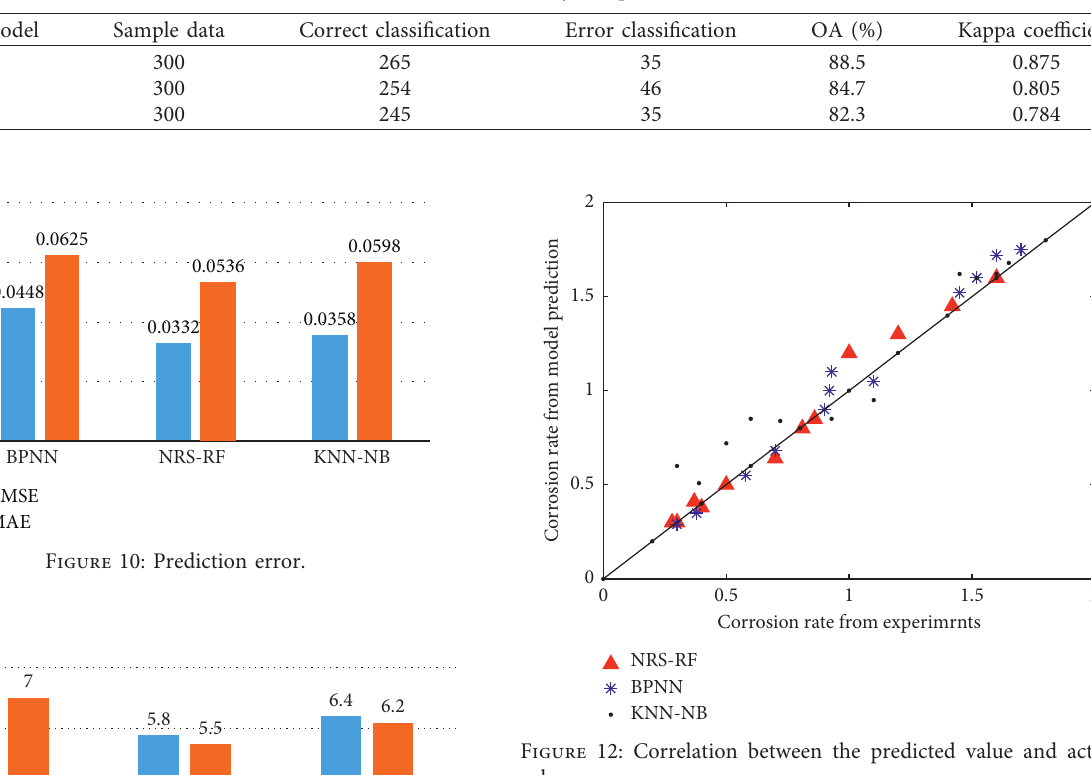
Table 3: Prediction accuracy comparison.